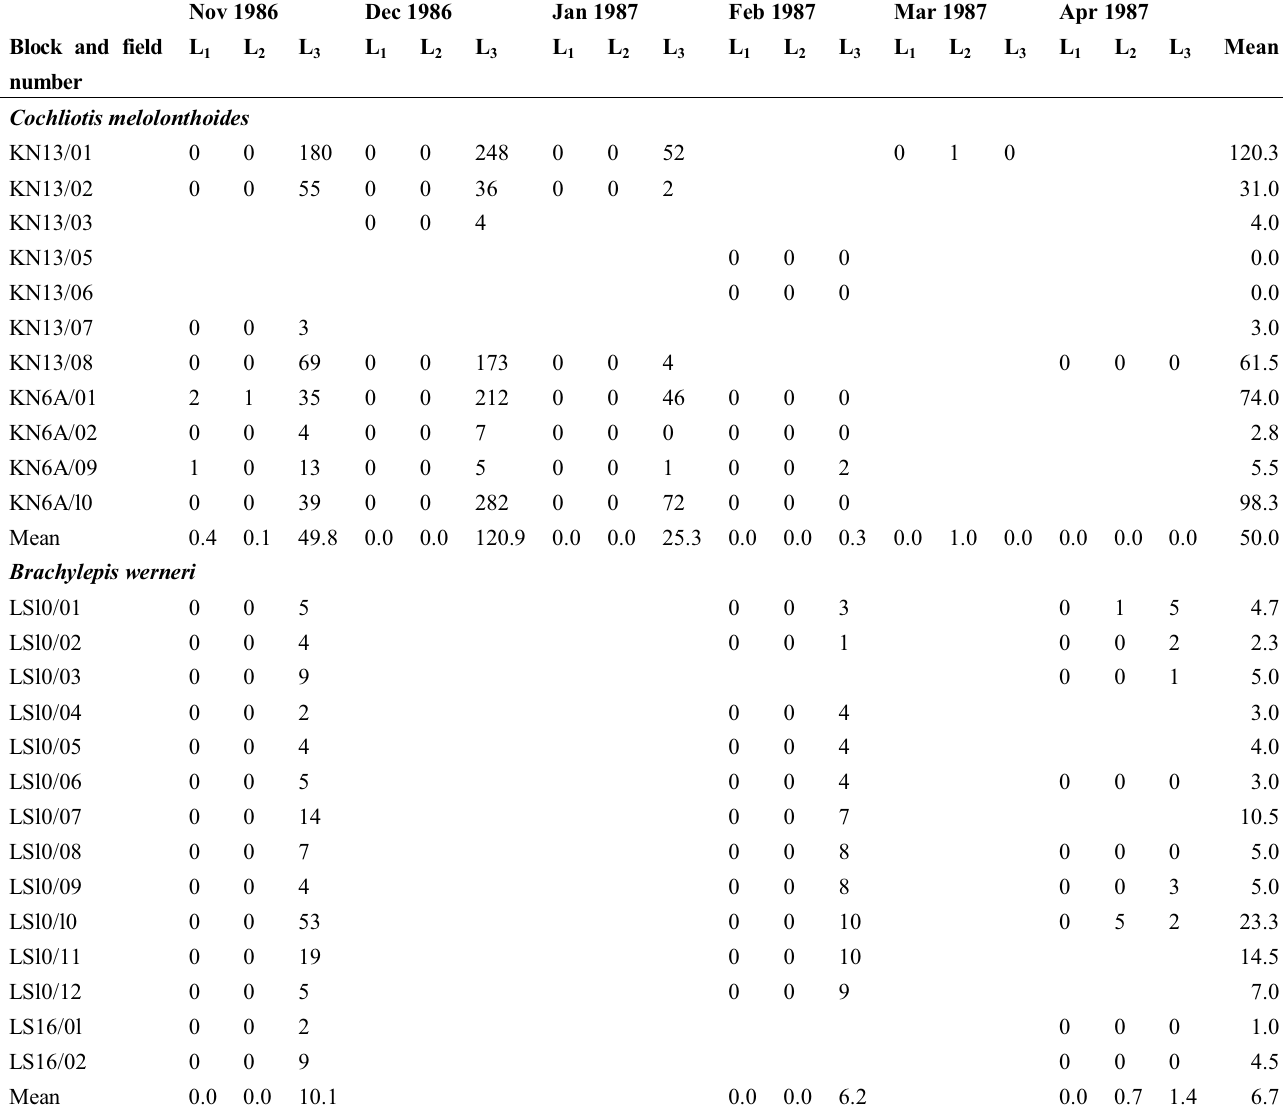
Table 2. Collated totals of twenty 0.5 × 0.5 × 0.5 m pit samples of larvae of Cochliotis melolonthoides and Brachylepis werneri from different fields in selected blocks at